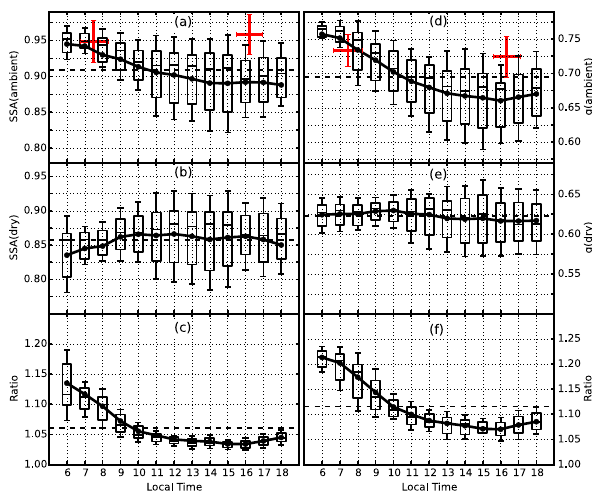
Figure 2. The diurnal variations of SSA and g at 550nm, (a) aver- age diurnal pattern of SSA for ambient aerosol and average SSA at 440 nm from AERONET site Xianghe (red plus symbol); (b) av- erage diurnal pattern of SSA for dry-state aerosol; (c) the ratio between (a) and (b) ; (d) average diurnal pattern of g for ambient aerosol and average g at 440nm from AERONET site Xianghe (red plus symbol); (e) average diurnal pattern of g for dry state aerosol; (f) the ratio between (d) and (e) . Black lines are the average diurnal variations, and dashed lines are their corresponding averages. Box plots give the data points range from 25th to 75th percentile, and bars outside the boxes give the range within 5th to 95th percentile. Lines in boxes are medians. The x and y dimensions of the red plus symbol represent the standard deviations of SSA or g and the local time when data points are sampled,